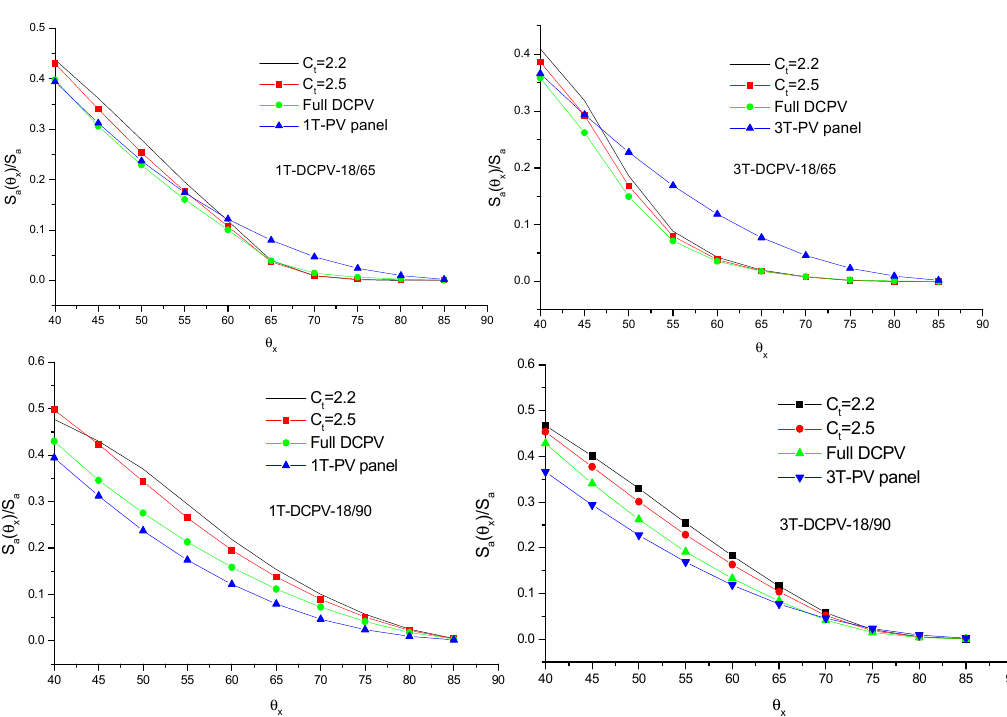
Figure 25. Angular distribution of annual collectible radiation on solar cells in terms of S a ( θ x )/S a . Effects of geometry of DCPC on f a C pv , the photovoltaic performance coefficient of DCPVs as compared to similar non-concentrating PV panel, are presented in Figure 26. It shows that f a C pv always decreases with the increase of θ e except for slightly truncated 3T-DCPV-10/ θ e ( C t = 5) where f C slightly increase for a pv